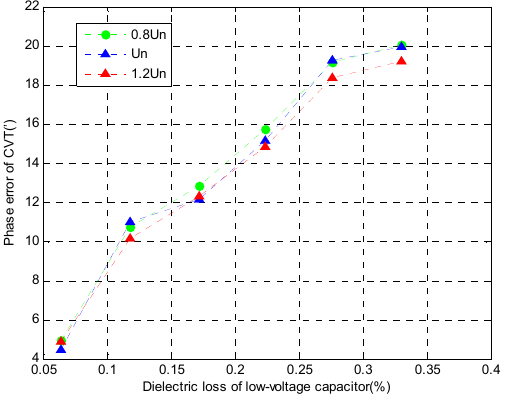
Figure 20. CVT phase error with different low-voltage capacitor dielectric loss factor.